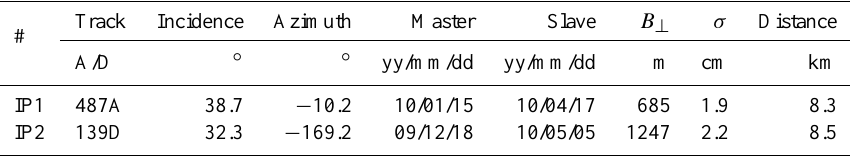
Table 1. Details of SAR data used in the study ∗ . Track Incidence Azimuth Master Slave B ⊥ σ Distance # A/D ◦ ◦ yy/mm/dd yy/mm/dd m cm km IP1 487A 38.7 − 10.2 10/01/15 IP2